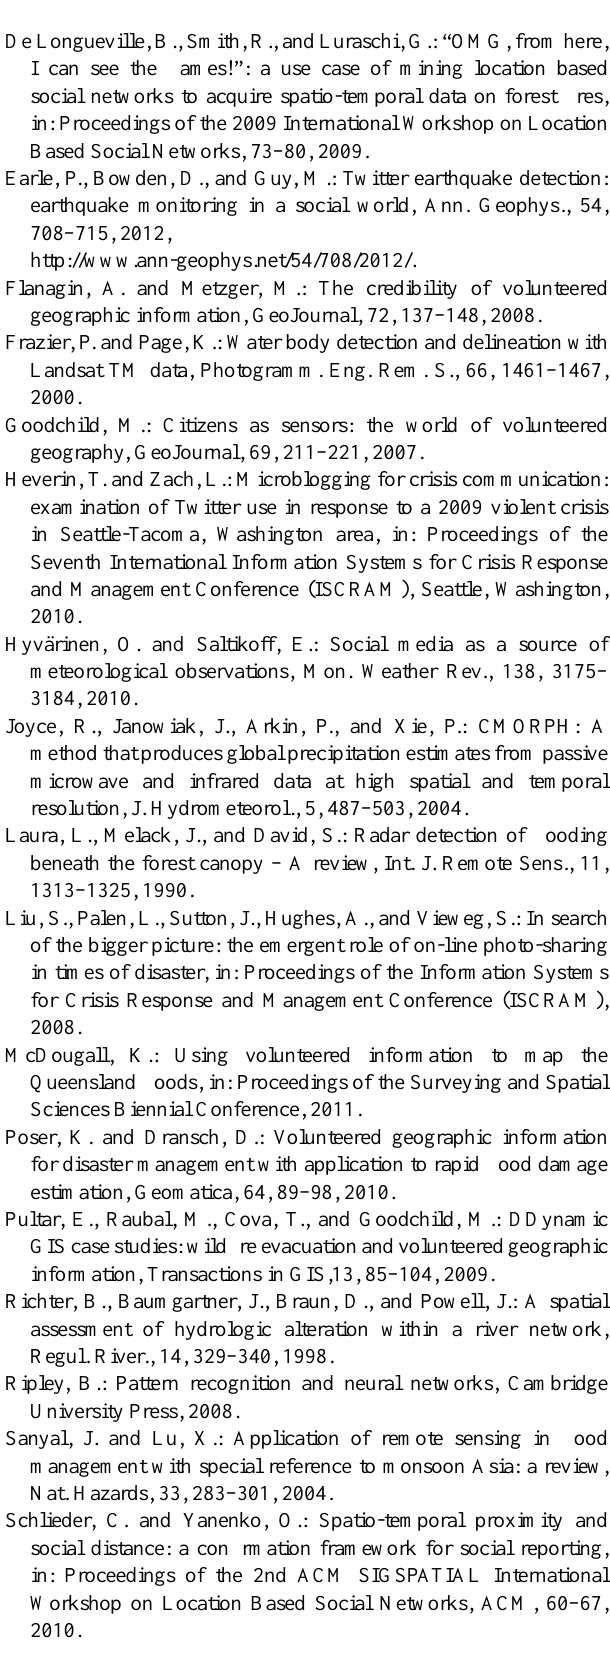
Table 1: Number of pixels classified as water.